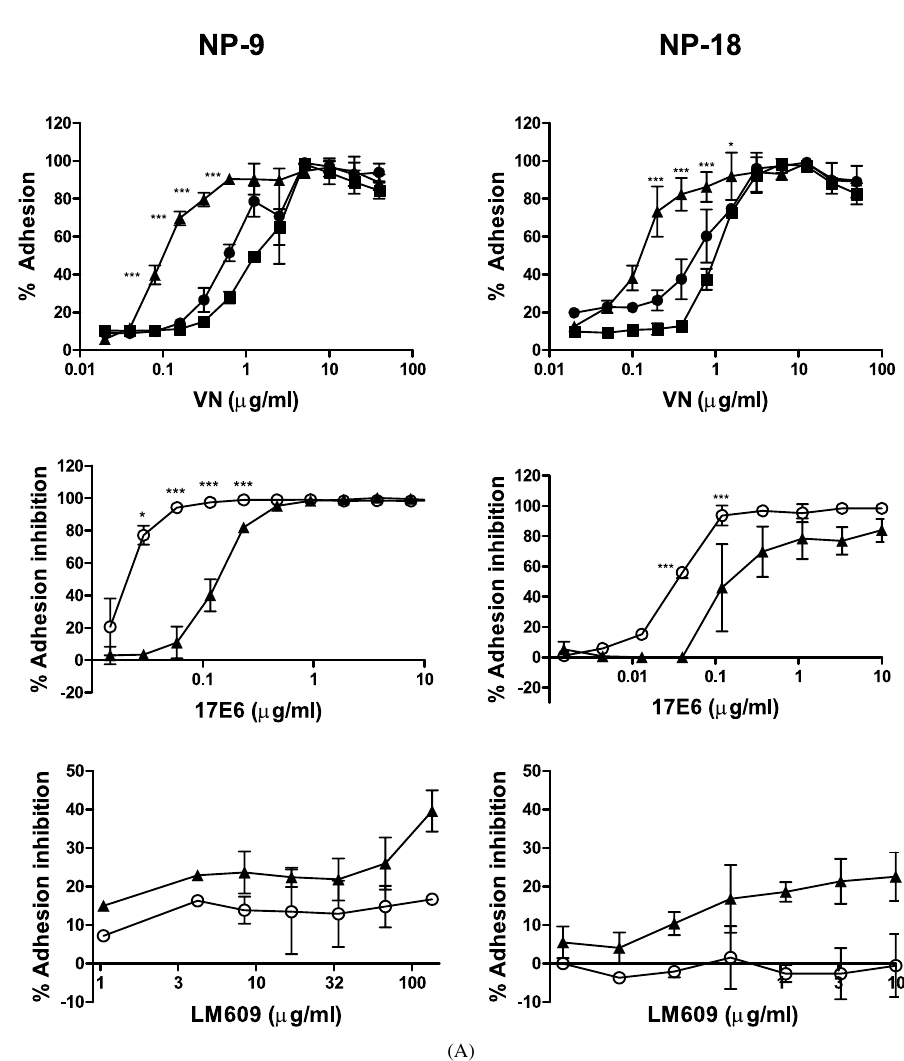
Fig. 3. Cell adhesion and adhesion inhibition assays. (A) Vitronectin (VN). For adhesion assays, results are presented as % of the maximum OD value of crystal violet-stained cells, working with sample triplicates in each experiment ( n = 3). Symbols represent the following cell lines: ( " ) wt, ( (cid:3) ) mock, and ( Q ) β 3 -transfected. For adhesion inhibition assays, purified monoclonal antibodies (mAb) against α v (17E6) or α v β 3 (LM609) were co-incubated during cell attachment to VN-coated substrates. Symbols represent the following conditions: ( ◦ ) wt 17E6/LM609; ( Q ) β 3 17E6/LM609. Data are expressed as a percentage of cell adhesion inhibition. In all cases, means ± SD are shown. Statistics: 2-way ANOVA, * p < 0 . 05, ** p (cid:2) 0 . 01, *** p (cid:2) 0 . 001 vs. wt or